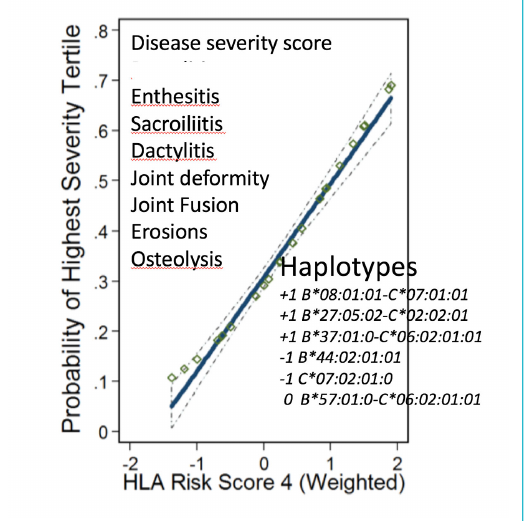
Figure 6: This illustrates a propensity analysis that analyzed the severity of psoriatic arthritis as a function of the interaction of sus- ceptibility alleles present on both maternal and paternal haplo- types. It shows the contribution of positive and negative risk alleles on both chromosomes to psoriatic arthritis severity is best ex- plained by an additive model of subphenotypes that results in a composite severity